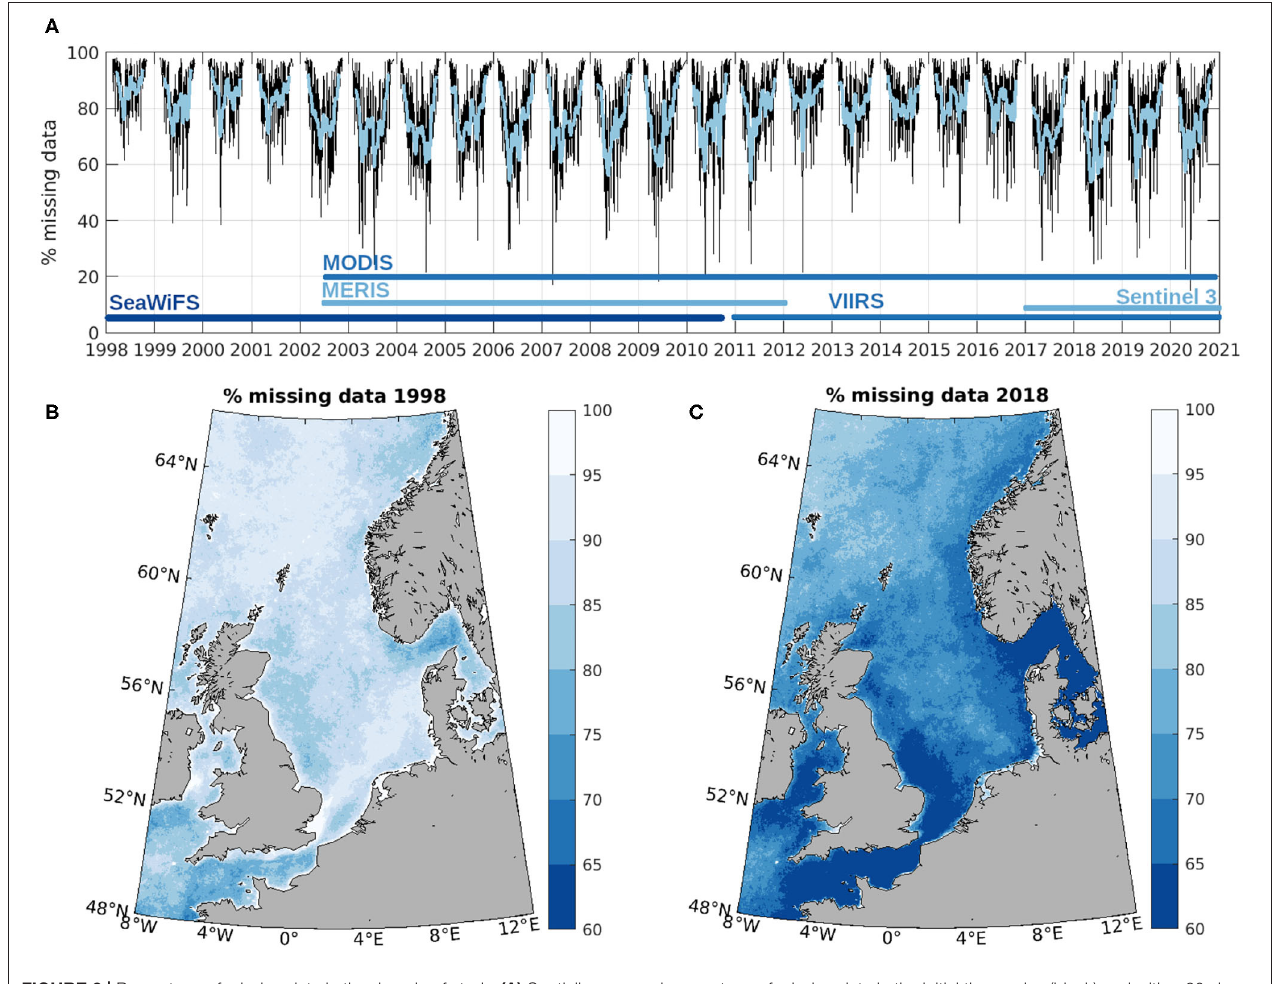
FIGURE 2 | Percentage of missing data in the domain of study. (A) Spatially averaged percentage of missing data in the initial time series (black) and with a 30-day Gaussian low-pass filter (blue). (B) Temporal average of the percentage of missing data for 1998 (year with the highest average percentage of missing data). (C) Temporal average of the percentage of missing data for 2018 (year with the lowest average percentage of missing